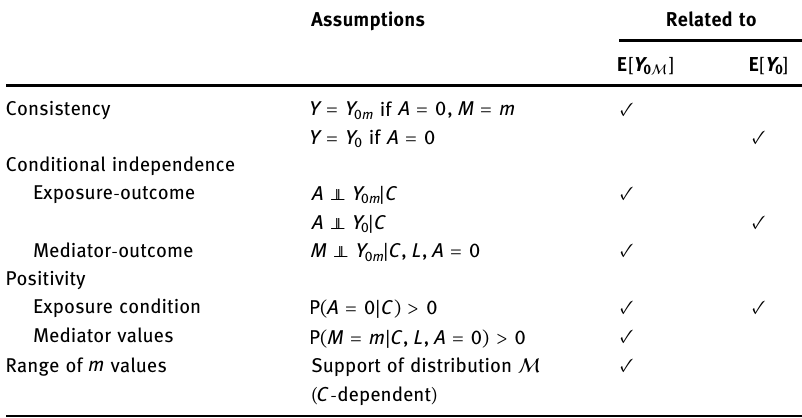
Table 4: Identifying assumptions for τ 1